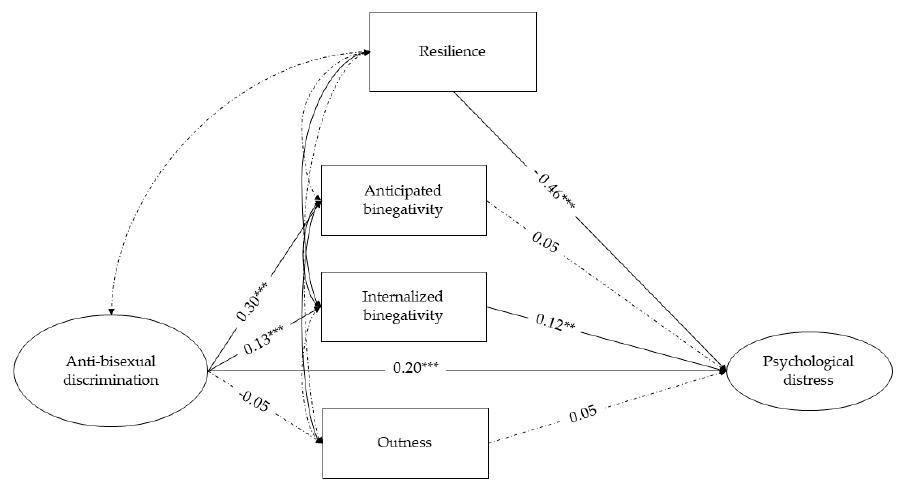
Figure 2. Results from the mediational model. Note. Solid and dashed lines represent significant and nonsignificant paths, respectively. The coefficients are referred to standardized estimates. For simplicity, associations with control variables are omitted. ** p < 0.01, *** p < 0.001.